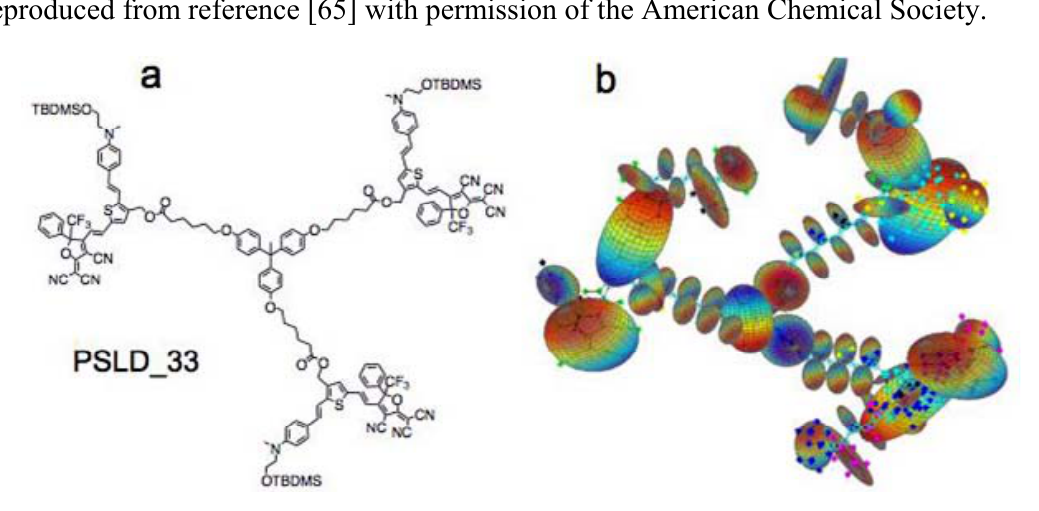
Figure 3. Chemical and Pseudo-Atomistic structures for an EO dendrimer are shown. Reproduced from reference [65] with permission of the American Chemical